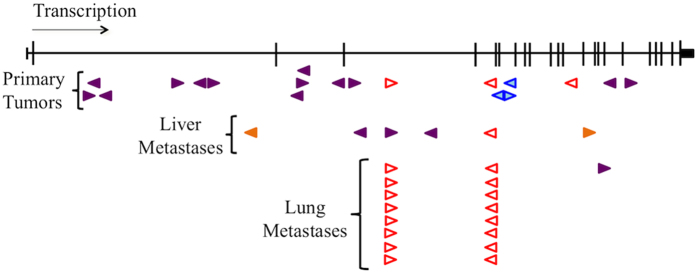
Sleeping Beauty transposon insertion profile predicts Srgap2 is a tumor suppressor.Arrows denote transposon insertion sites, which point in the direction of the promoter. Three animals had multiple insertions in Srgap2, represented by the red open arrows, the blue shaded arrows, and the solid orange arrows. All remaining insertion sites, represented by solid purple arrows belong to different animals. The insertion profile predicts Srgap2 is a tumor suppressor due to the unbiased transposon insertion throughout the gene without a promoter direction preference.